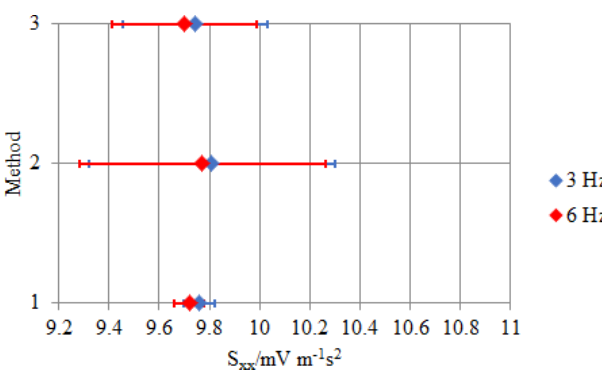
Figure 4. Piezo-electric accelerometer: comparison between meth- ods (main sensitivity along the y axis, S yy